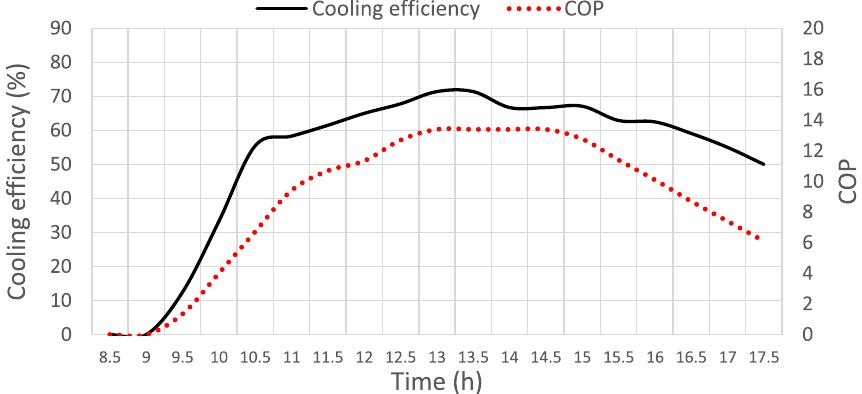
Fig. 13 Variation of cooling efficiency and COP with time for day